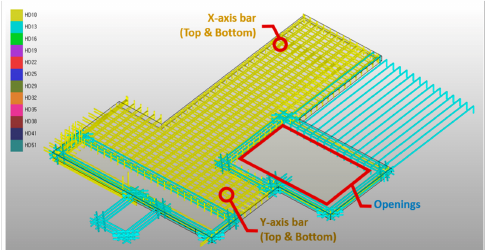
Figure 5. Example of the rebar arrangement of slab members and the name of the rebar for each part (1F, Building #101 of construction project